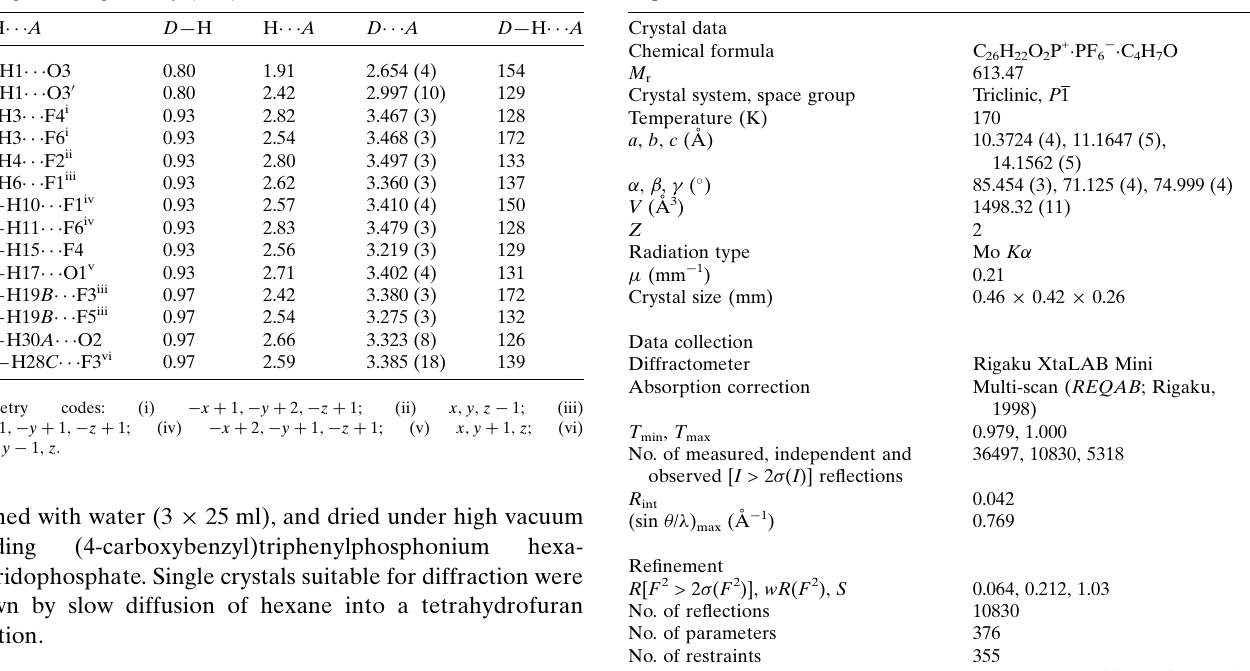
Table 1 Hydrogen-bond geometry (A˚ , (cid:6)